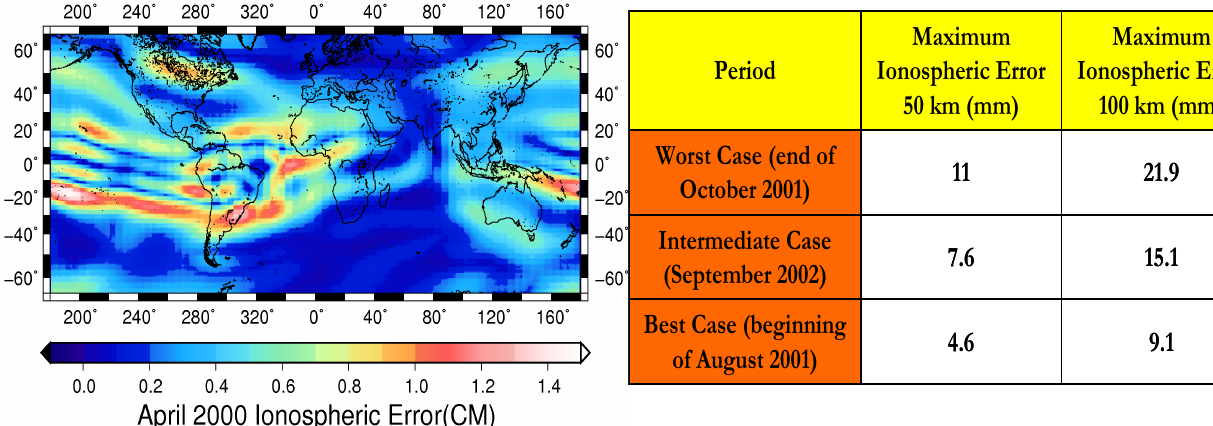
Figure 12. (a) Example of the spatial distribution of the FR ionospheric errors (differences between the nadir and the off-nadir delays) in an intermediate case at midnight in April 2000 (b) Maximum ionospheric errors in the swath (Middle Range and Far Range) in different cases.